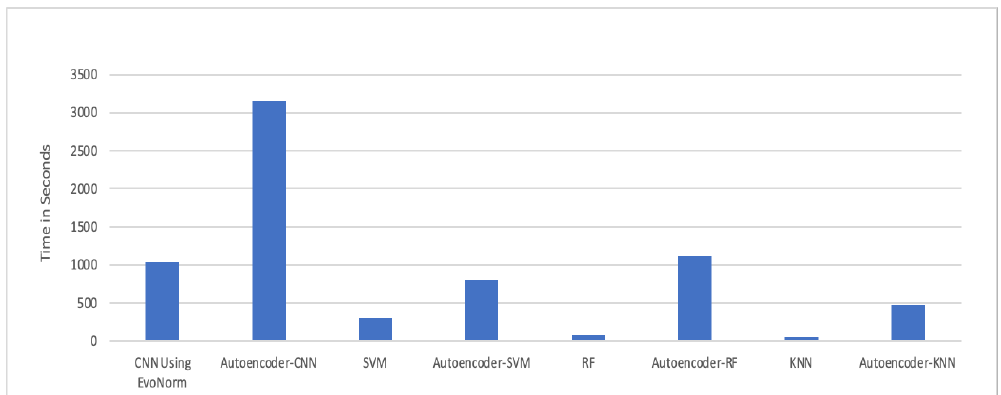
Figure 19. Computational time (s).